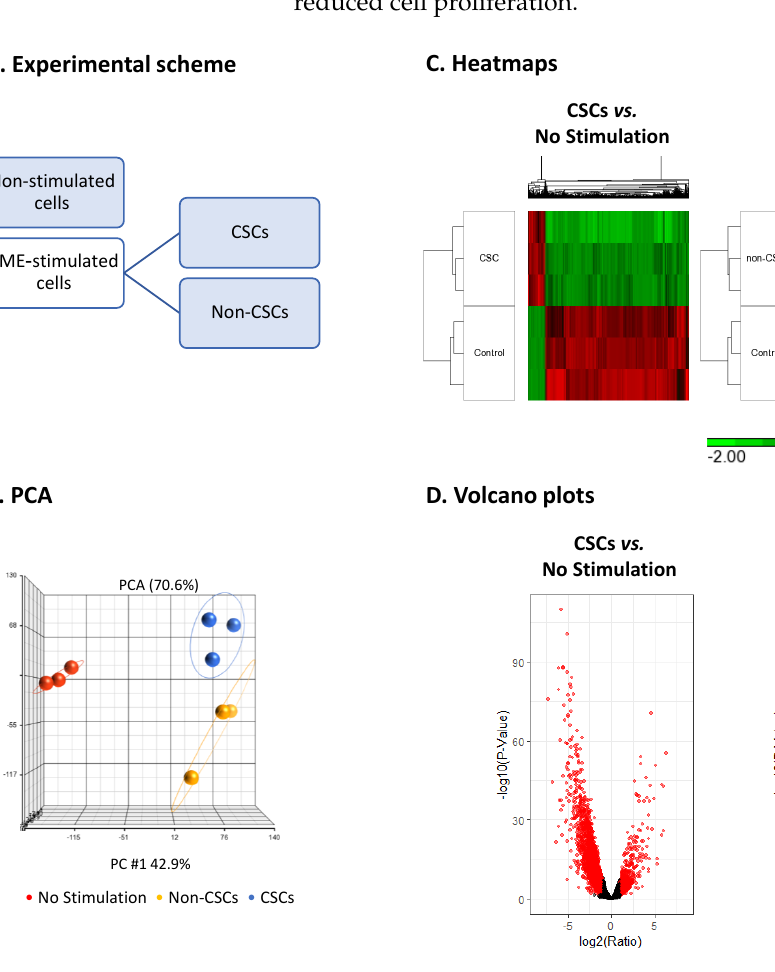
Figure 2. TME Stimulation leads to substantial modifications in gene expression in TME-stimulated CSCs and TME-stimulated Non-CSCs in MCF-7 HR+/HER2 − cells: MCF-7 cells that were exposed to TME Stimulation for 96 h (concentrations as described in Figure 1) were sorted based on the CD44 + and CD24 low/ − markers to CSCs and Non-CSCs. In parallel, a group of non-stimulated cells (“No Stimulation”; includes the entire cell population) was analyzed (after 96 h in culture with the vehicles). Gene expression in these three groups of cells were determined by RNAseq. Cell sorting and RNAseq analyses were performed on three independent biological repeats. ( A ) An experimental scheme of the experiment, noting in blue the cell groups that were analyzed by RNAseq. ( B ) Principal component analysis (PCA) of three replicates in each of the three cell groups. ( C ) Heatmaps and ( D ) volcano plots of differentially expressed genes that passed the cutoff FC ≥ 2 or FC ≤ − 2, with pFDR < 0.05 for the following comparisons: TME-stimulated “CSCs” compared to “No Stimulation”; TME-stimulated “Non-CSCs” compared to “No Stimulation”; TME-stimulated “CSCs” compared to TME-stimulated “Non-CSCs”. In Part ( D ), red dots mark genes passing the FC and significance